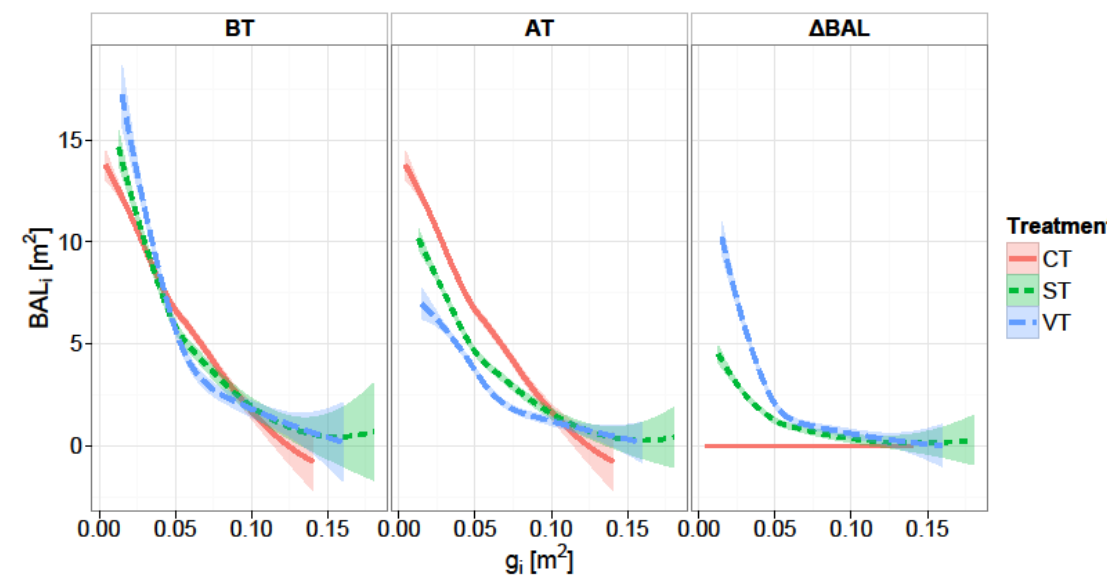
Figure 1. Basal area of larger trees ( BAL ) before and after thinning (BT, AT) and change in basal area of larger trees after thinning (Δ BAL i ) versus initial tree basal area ( g i ) for the different treatments: control (CT), strong thinning (ST), and very strong thinning (VT). The shaded areas indicate the standard errors of the